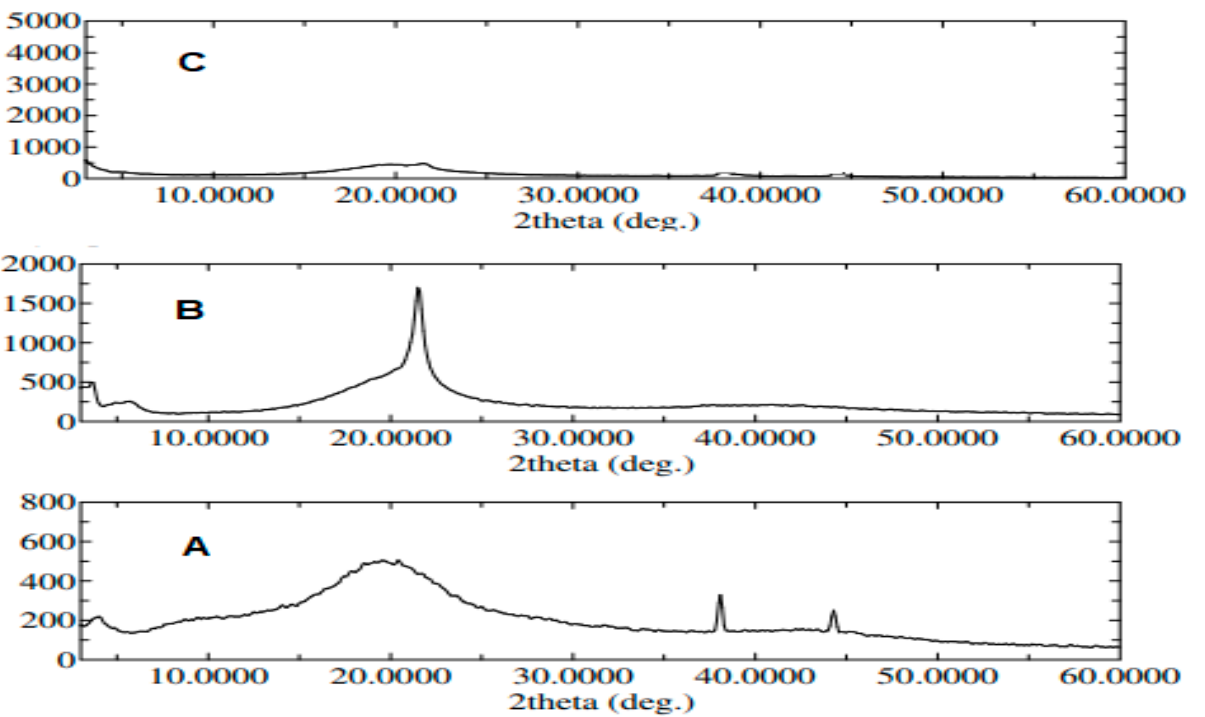
Figure 6. XRD of ( A ): pure ROS, ( B ): lecithin, span 60 and ROS physical mixture, and ( C ): the optimized formula.